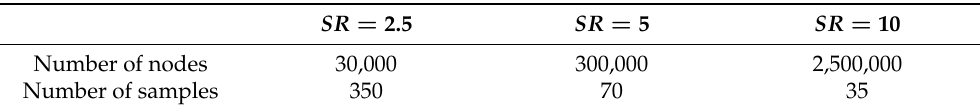
Table 2. Average number of nodes in the mesh and number of samples with inclusion volume fraction f v = 13.4 % for different scaling ratios SR with r = 10 µ m. SR = 2.5 SR = 5 SR =